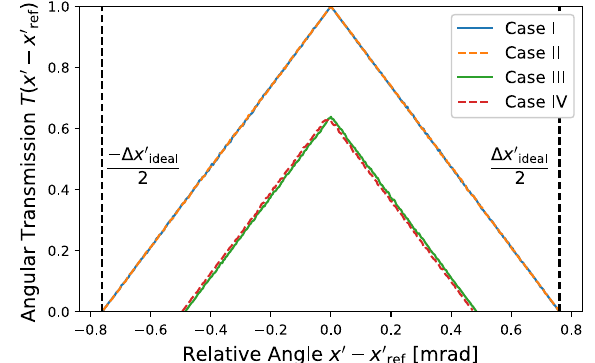
FIG. 4. Angular transmission factor T ð x 0 Þ for Cases I to IV in Fig.